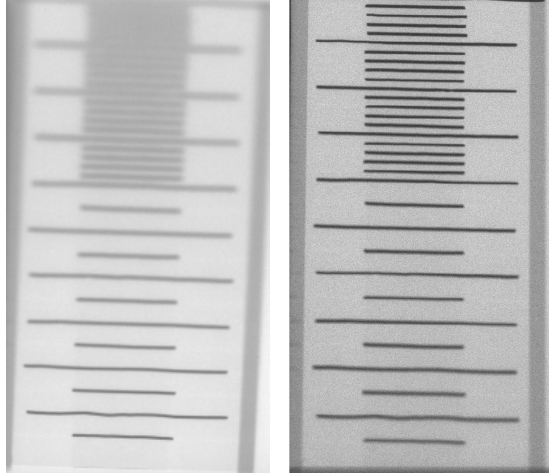
Fig. 7. The resulting image of the NU-device for the OB (left) and CB (right) configurations. Note: In general, sharp shadow lines (umbra shadow) of Cd- wires represent higher L/D value.